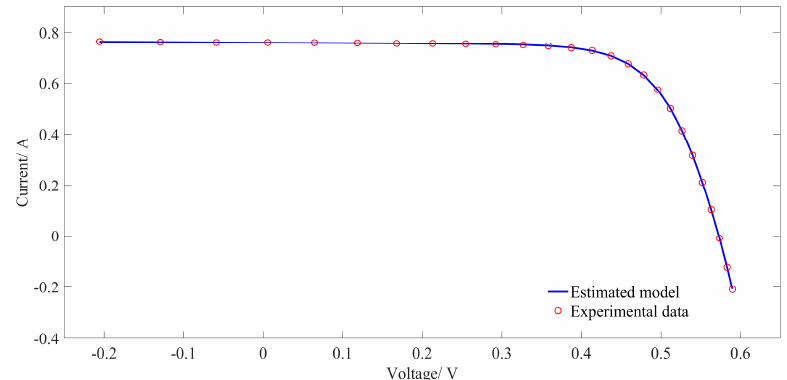
Figure 9. Comparison of estimated model and experimental data I - V characteristics of double diode model by HPSOSA.